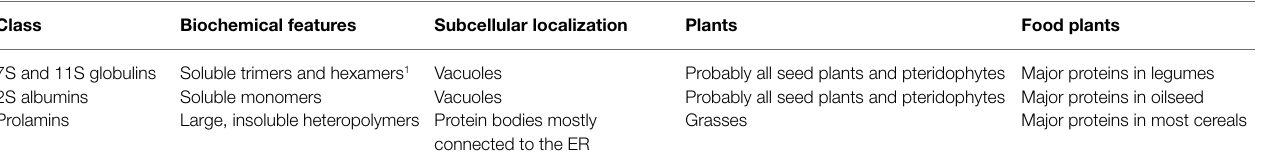
TABLE 1 | Main features of the major classes of seed storage proteins. Class Biochemical features Subcellular localization Plants Food plants 7S and 11S globulins Soluble trimers and hexamers 1 Vacuoles Probably all seed plants and pteridophytes Major proteins in legumes 2S albumins Soluble monomers Vacuoles Probably all seed plants and pteridophytes Major proteins in oilseed Prolamins Large, insoluble heteropolymers Protein bodies mostly Grasses Major proteins in most connected to the ER